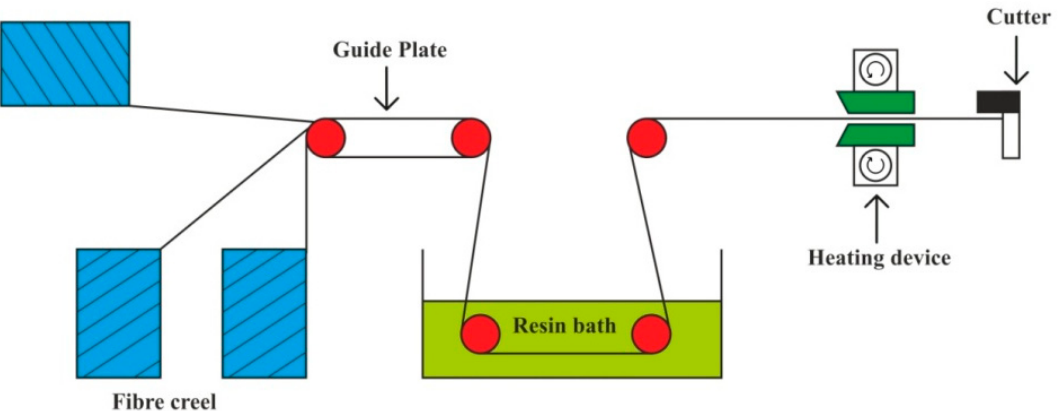
Figure 9. Pultrusion process.